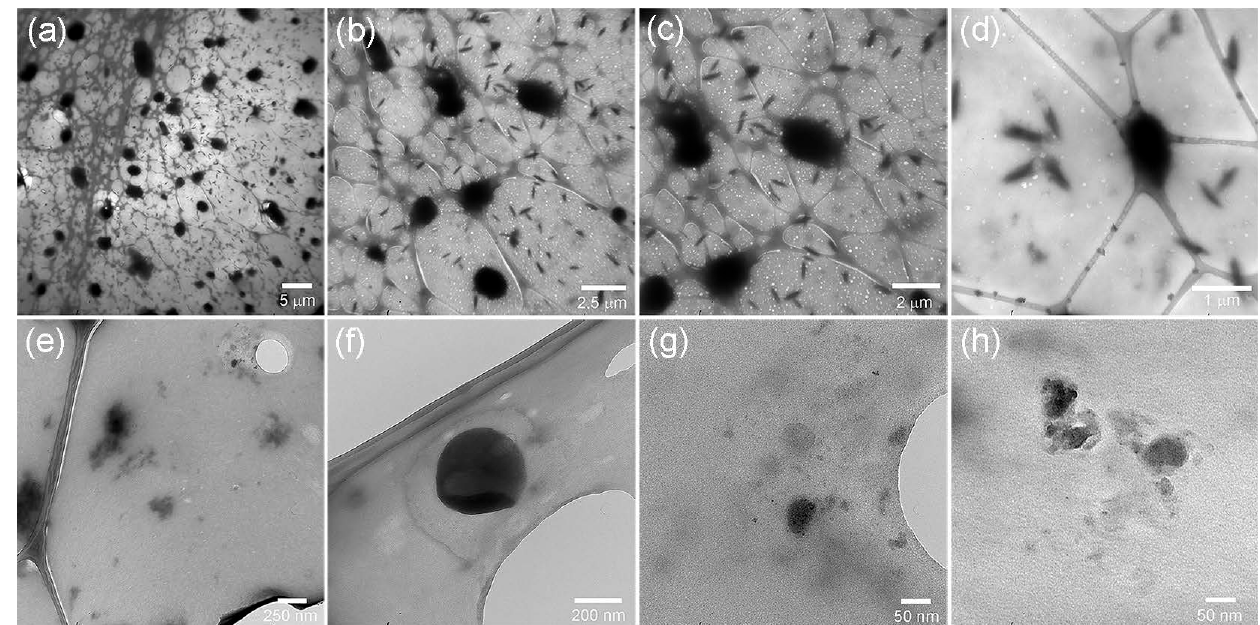
Figure 4. SEM images of the dried hydrogel at different magnifications. ( a – c ) Images of the surface showing a homogeneous distribution of porous with the presence of elongated and agglomerated particles of allantoin in the matrix and on the surface, ( d , e ) magnifications of elongated and agglomerated particles of allantoin in the matrix, ( f – h ) magnifications of agglomerated particles of allantoin on the surface.